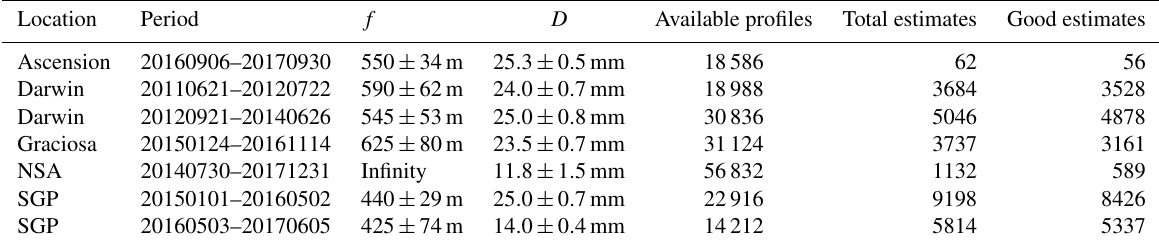
Table 3. Best estimates of f and D together with their uncertainties for Doppler lidars at five ARM sites. Total estimates refers to the number of ceilometer and Doppler lidar profiles suitable for comparison. Good estimates refers to the number of estimates remaining after outlier filtering with